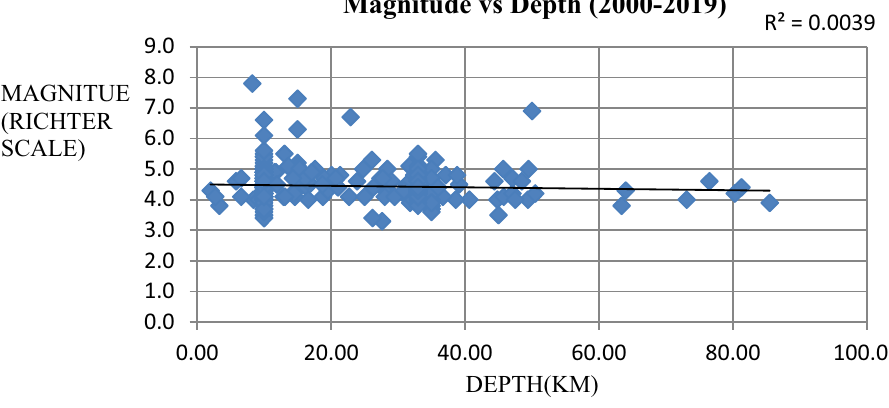
Fig. 5 Graphical representa- tion of earthquake depth ver- sus magnitude for the period